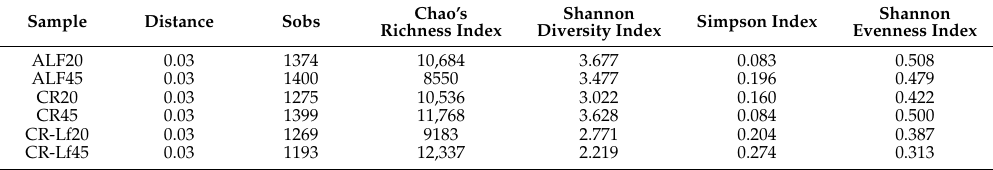
Table 2. Common ecological parameters of alpha diversity for the microbial communities analyzed.